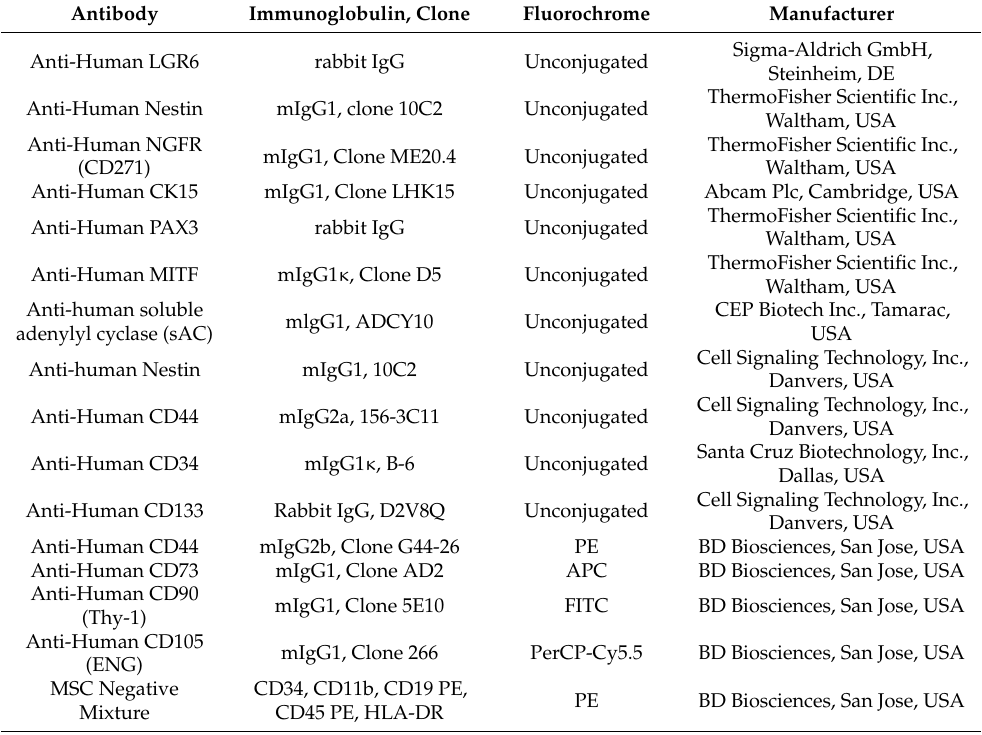
Table 1. Primary antibodies used for immunofluorescent staining and flow cytometry (FCM)